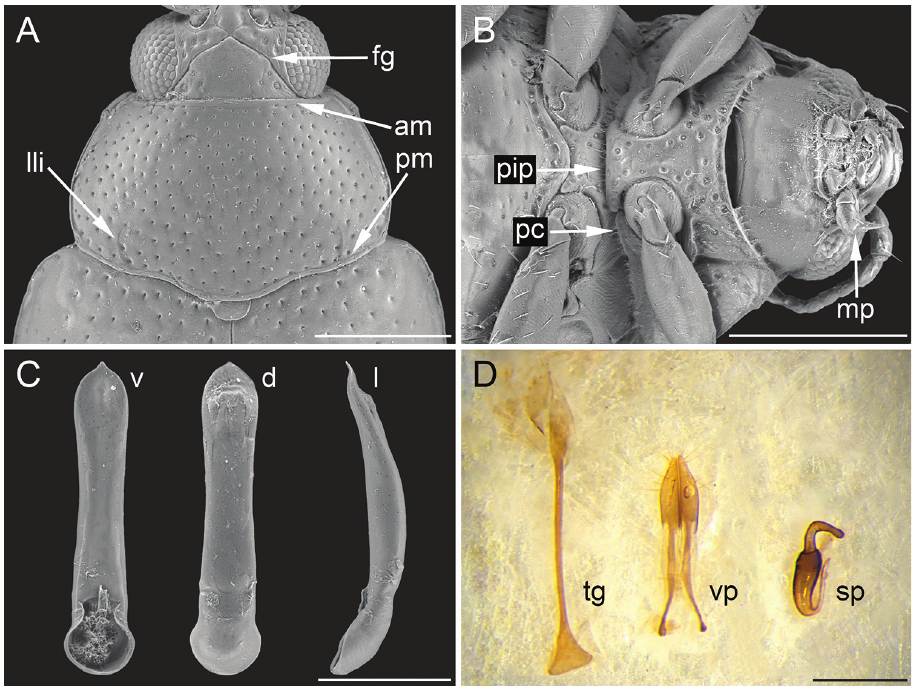
Figure 4. Morphological characters of Bezdekaltica socotrana Döberl, paratypes, Yemen, Socotra Island, Dixam plateau, Firmihin, Dracaena forest, 12°28.6 ' N, 54°01.1 ' E, 490 m, 15–16.xi.2010, J. Bezd ĕ k leg. (BAQ). A pronotum: am = anterior margin, fg = frontal groove, lli = lateral longitudinal impression, pm = posterior margin B Head in ventral view, prosternum and mesosternum: mp = maxillary palpus, pc = procoxal cavity, pip = prosternal intercoxal process C Aedeagus: d = dorsal view, l = lateral view, v = ventral view D Female genitalia: sp = spermatheca, tg = tignum, vp = vaginal palpi. Scale bar: 250 µm ( A ); 300 µm ( B ); 200 µm ( C ); 150 µm ( D